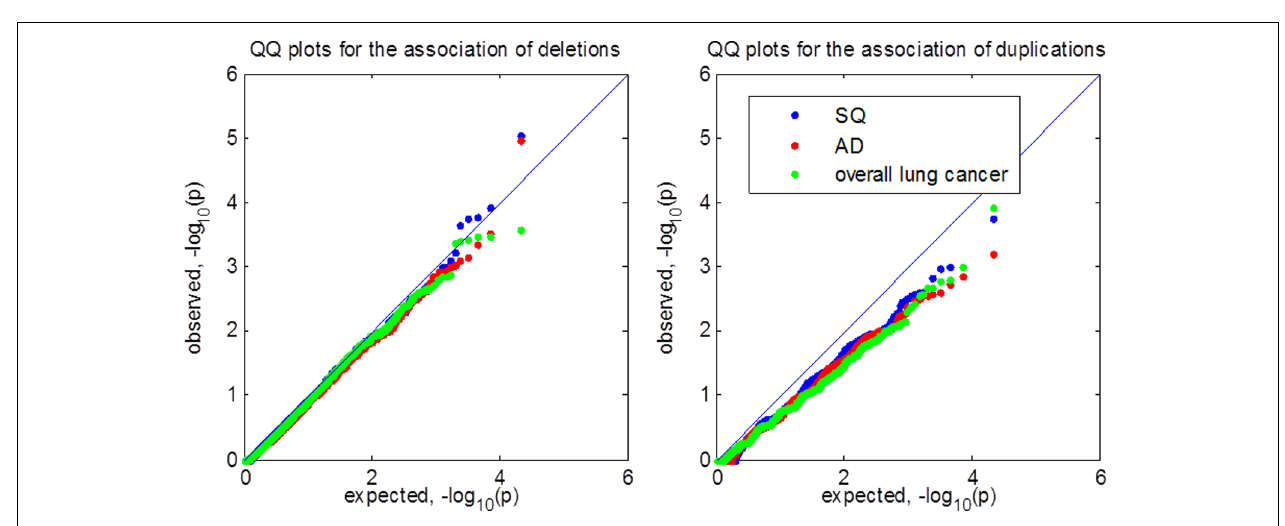
covered by the deletions. “ideal” represents the power when CNV status is known. “VTET-20 (40)” is the power for detecting CNV associations in a genomic region with 20 (40) probes using VTET. The power for CNVtools was estimated based on simulations successfully run by CNVtools.